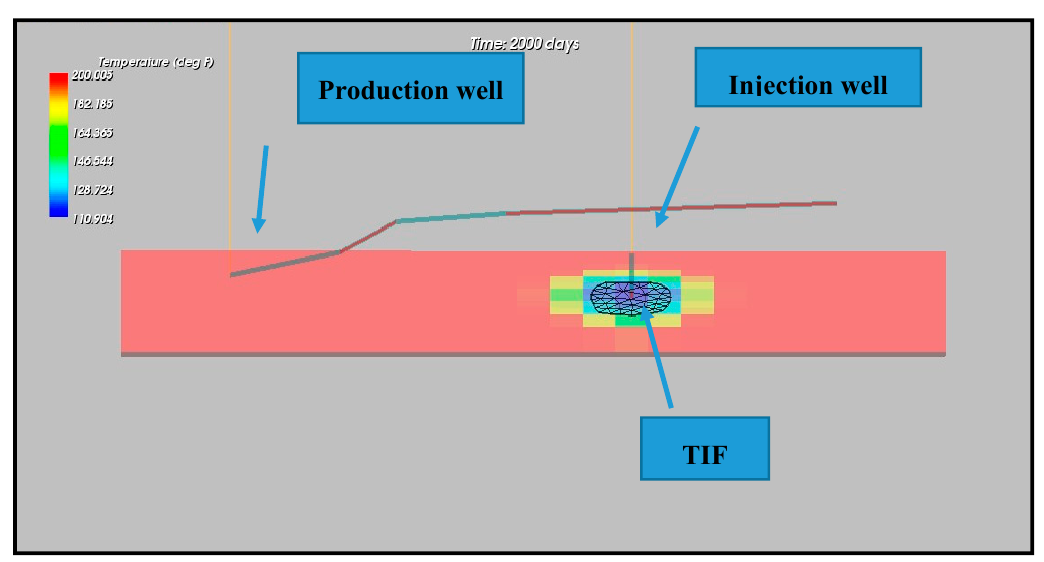
Figure 1. Temperature evolution around a vertical water injector [4].